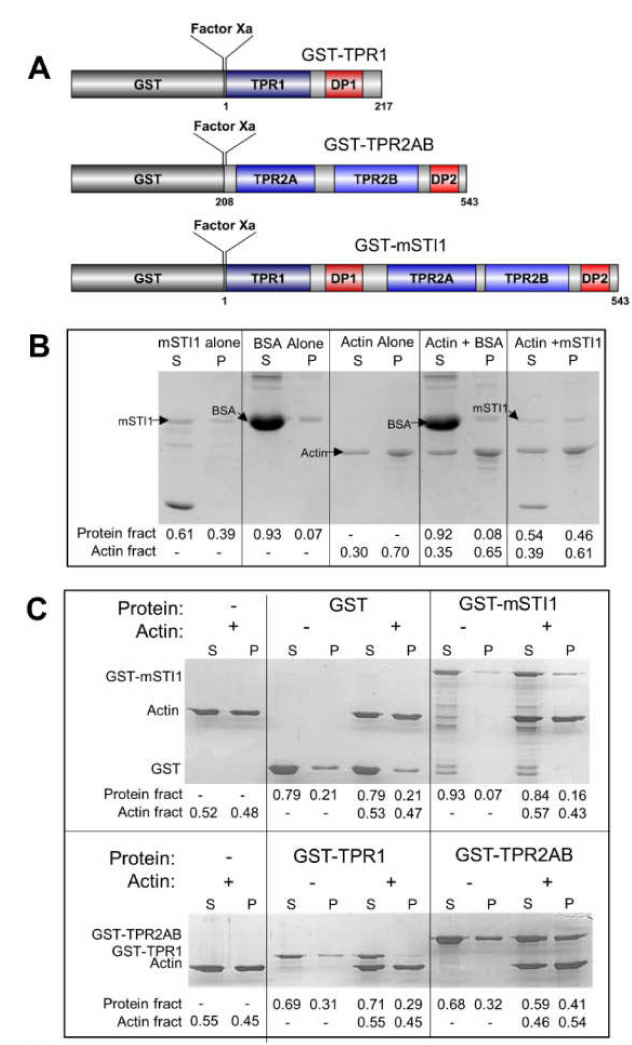
Figure 1. mSTI1 interacts with F-actin. ( A ) Schematic diagram of the recombinant GST-tagged mSTI1 proteins used. Factor Xa represents a cleavage site between the GST-tag and mSTI1. ( B )